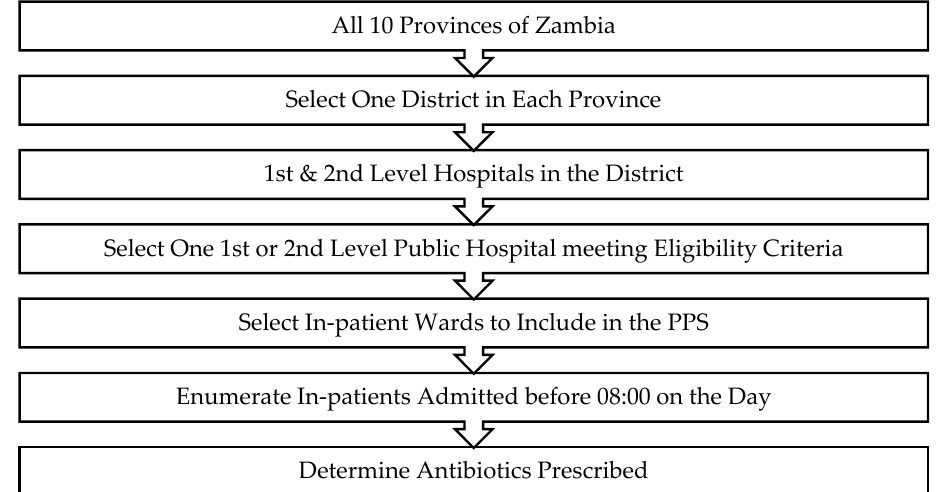
Figure 3. Flow plan of the PPS conducted in Zambia.